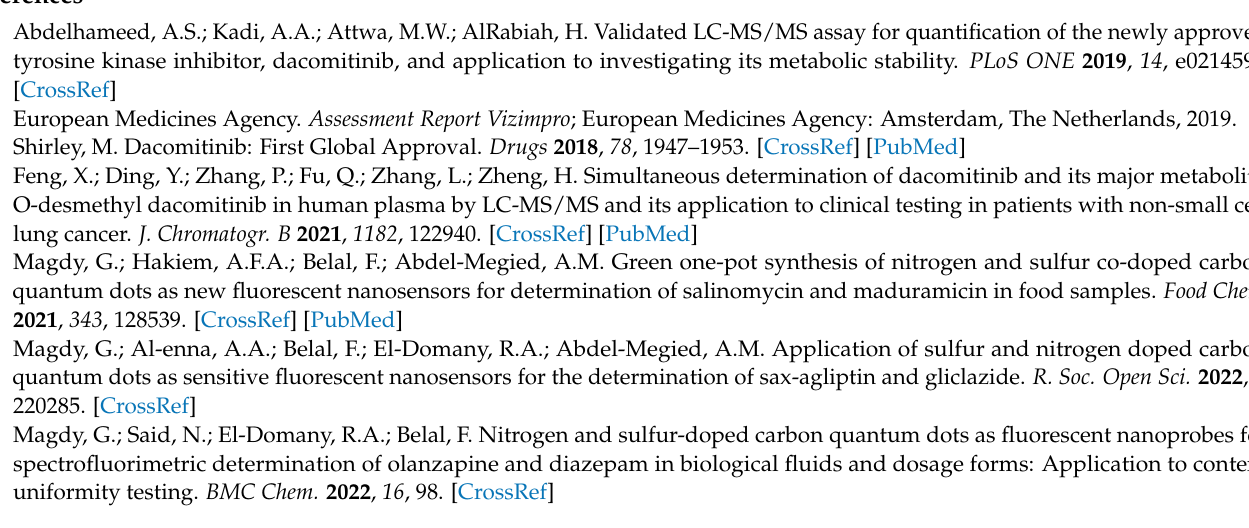
Figure S3: Fluorescence spectra of N-CQDs; (a) excitation and (b) emission spectra; Figure S4: The typical HRTEM image of N-CQDs; Figure S5: TEM-EDX analysis of the prepared N-CQDs; Figure S6: FTIR spectrum presenting the surface functionality of